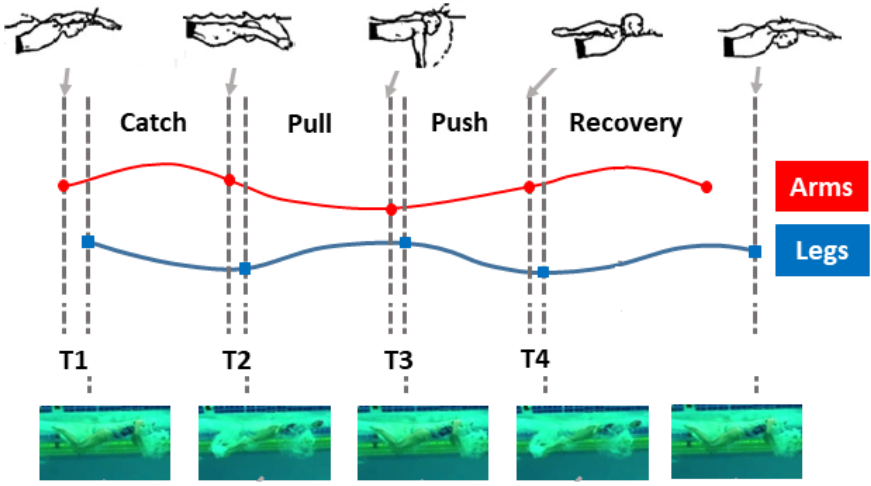
Figure 1. Butterfly stroke: arm and leg phases (case of T 2 , T 3 , T 4 > 0) according to